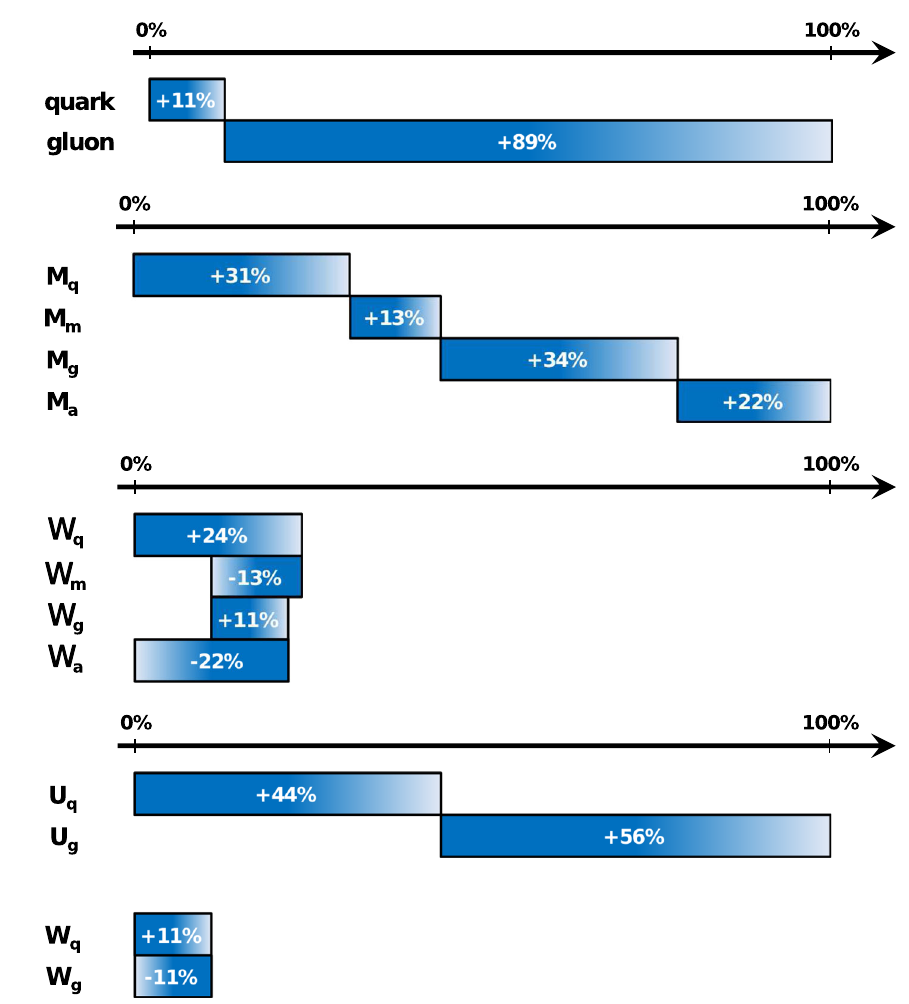
Fig. 4 New decompositions of the nucleon mass and pressure–volume work (72) in units of M at the scale μ = 2